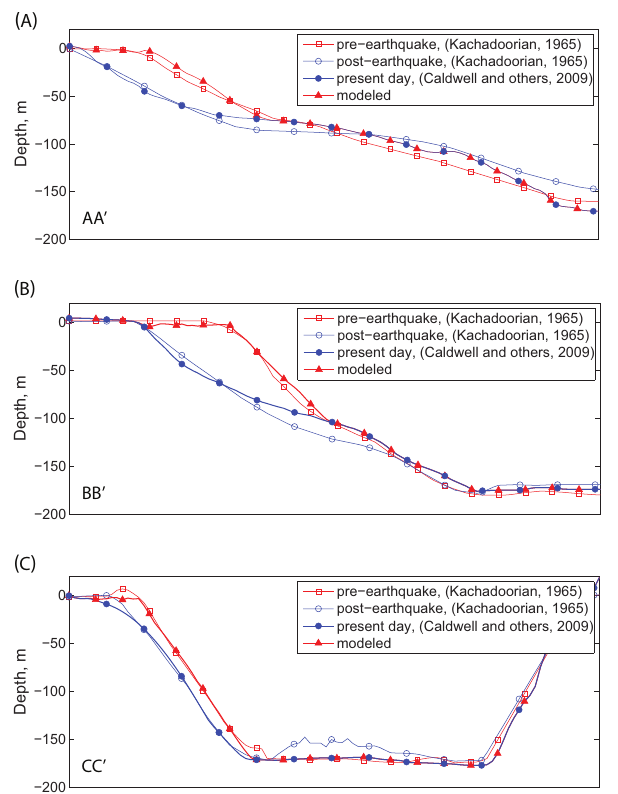
Fig. 4. Pre- and post-earthquake bathymetry profiles are shown by solid lines. The present day bathymetry profiles are shown by blue dotted lines. The modeled pre-1964 bathymetry profiles are shown by red dotted lines. The profile locations correspond to the transects AA 0 , BB 0 , and CC 0 shown in Fig. 2.